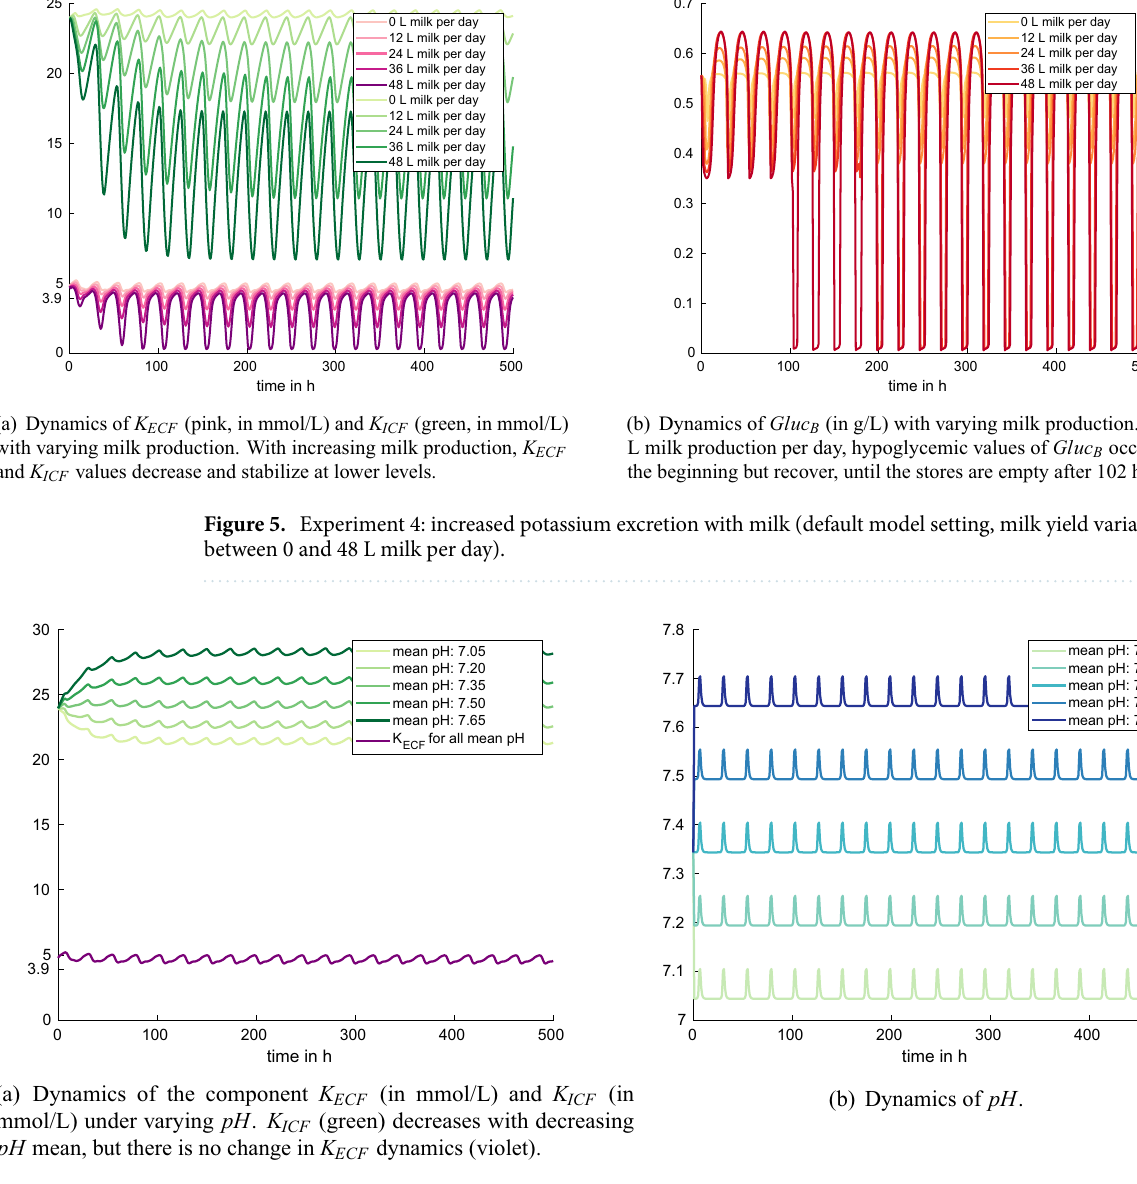
Experiment 4: increased potassium excretion with milk. With increasing milk production, the values for intra- and extracellular potassium content, K ECF and K ICF , decrease and stabilize at lower values (Fig. 5a). The blood glucose, Gluc B , is maintained within its physiological limits until stores are empty (Fig. 5b). For 48 L milk pro- duction per day, hypokalemic values of K ECF can be observed after 9 h. Values of Gluc B are hypoglycemic right from the beginning but recover until the stores are empty after 102 h. Since the model does not allow for varying potassium content in milk, milk increase leads to early hypokalemia. Redistribution. Changes in blood pH or medications can increase the shift of potassium from extracellular to intracellular space. The results of the corresponding numerical experiments are discussed in the following. Experiment 5: acidosis, alkalosis. Figure 6 shows the dynamics of the model components K ECF , K ICF , and pH during the experiments. When the model parameter p 85 is set to p 85 = { 7.2, 7.35, 7.5, 7.65, 7.8 } , this leads to mean pH values of 7.05, 7.2, 7.35, 7.5, and 7.65, respectively. With increasing pH , also K ICF increases, whereas the acid-base variations in the numerical experiments do not have any effect on extracellular potassium levels K ECF (Fig. 6a). The latter is in contradiction to experimental findings in humans 9 , and hence probably also in contradiction to what is happening in cows. Rastergar and Soleimani 9 describe the behaviour of potassium under changing pH conditions in humans. They observed that for each 0.1 unit change in pH, there is a change